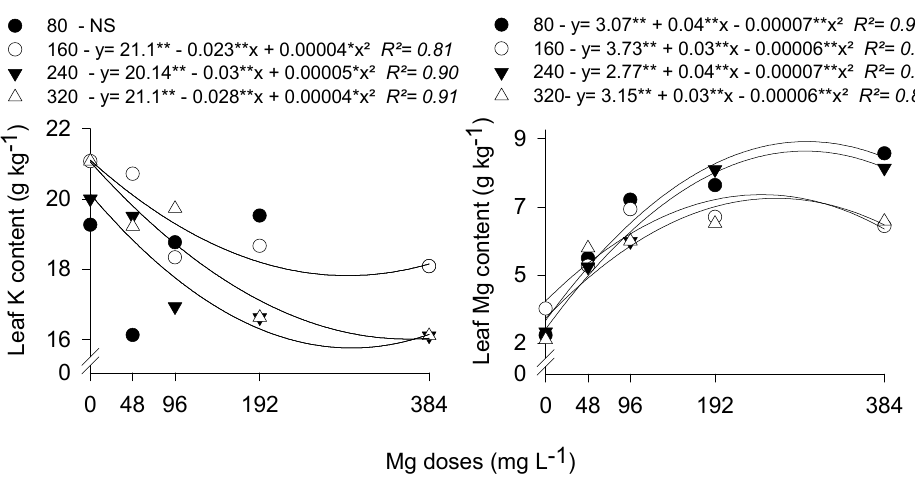
Figure 2. Contents of Mg and K in leaves of coffee seedlings grown with different Mg concentrations and under different light levels. (*) Significant according to the t test at p < 0.05. (**) Significant according to the t test at p < 0.01.